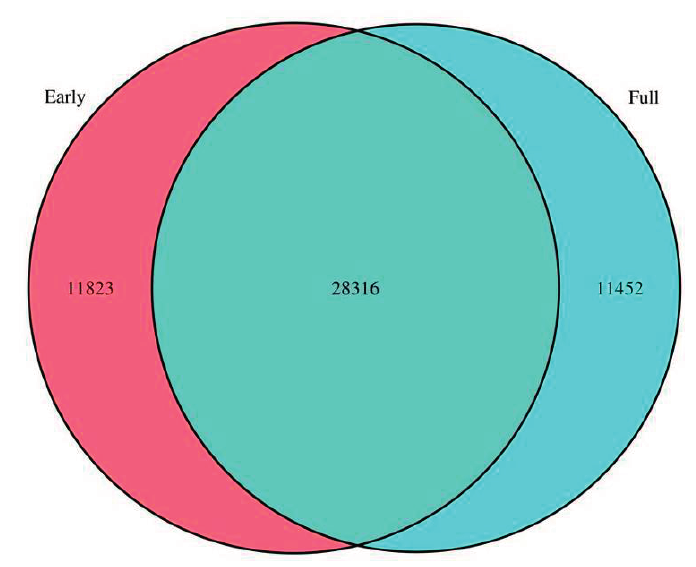
Figure 3. Safflower flowering gene expression statistics. The red represents genes that express in the early stage, and the blue represents genes that express in the full stage.